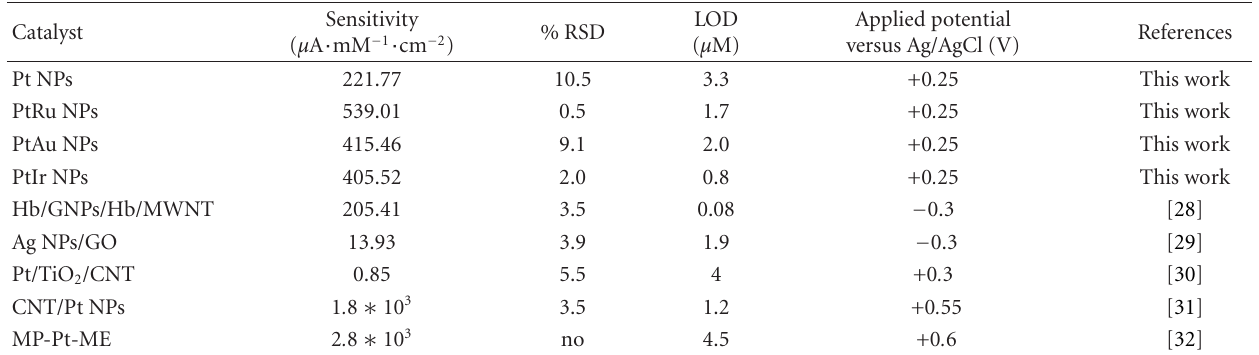
Table 1: Comparison of the performance of various H 2 O 2 sensors based on electrochemical measurement.